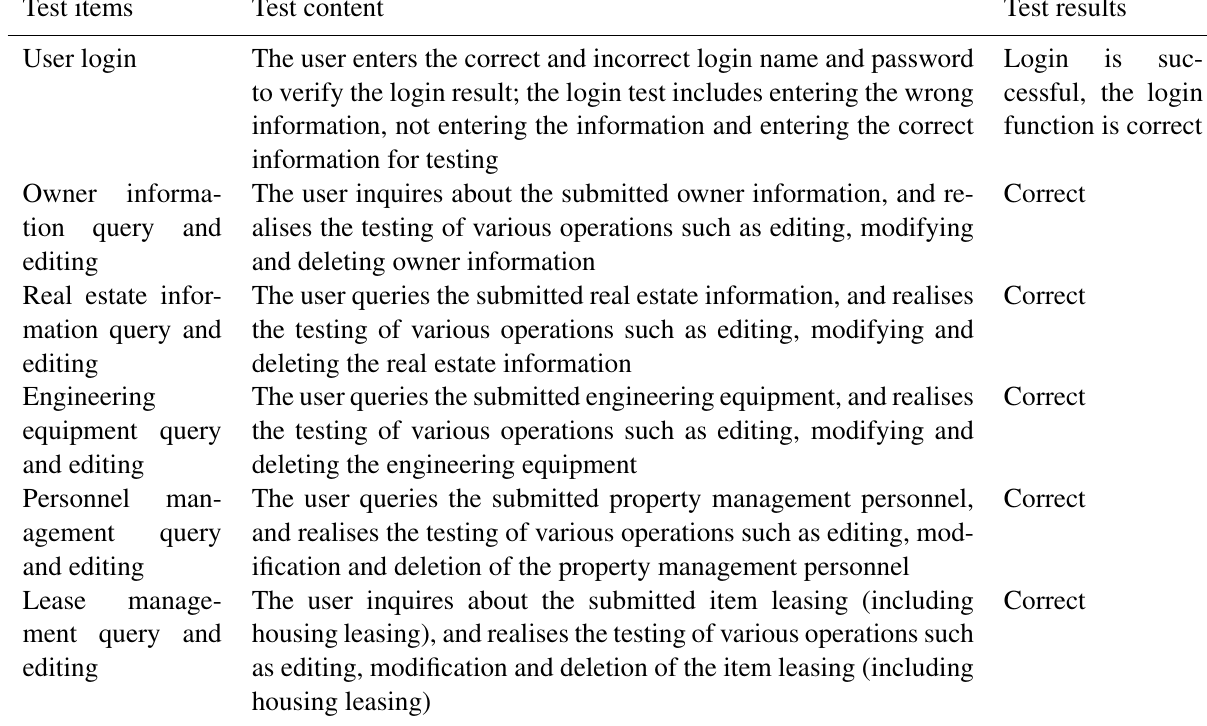
Table 1 System functional test